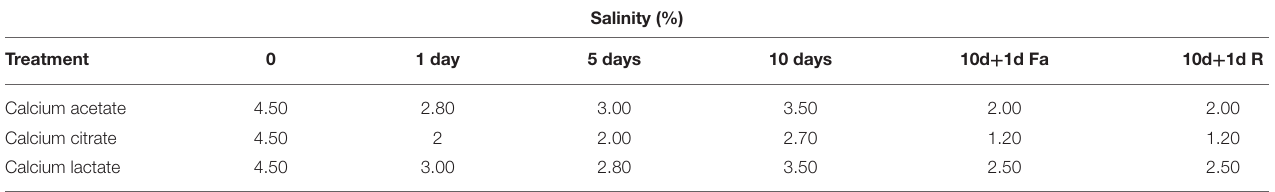
TABLE 3C | Salinity values during time course treatment of JFSW in brines with calcium acetate, citrate, and lactate at 1, 5, and 10